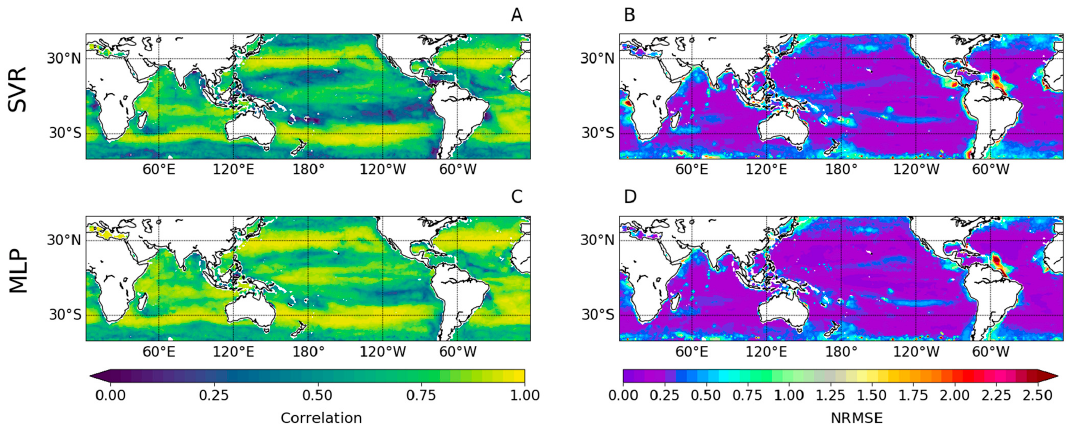
Figure 3. ( A , C ) Correlation and ( B , D ) NRMSE of Chl OC-CCI vs. (up) Chl SVR and (bottom) Chl MLP over 1998–2015.